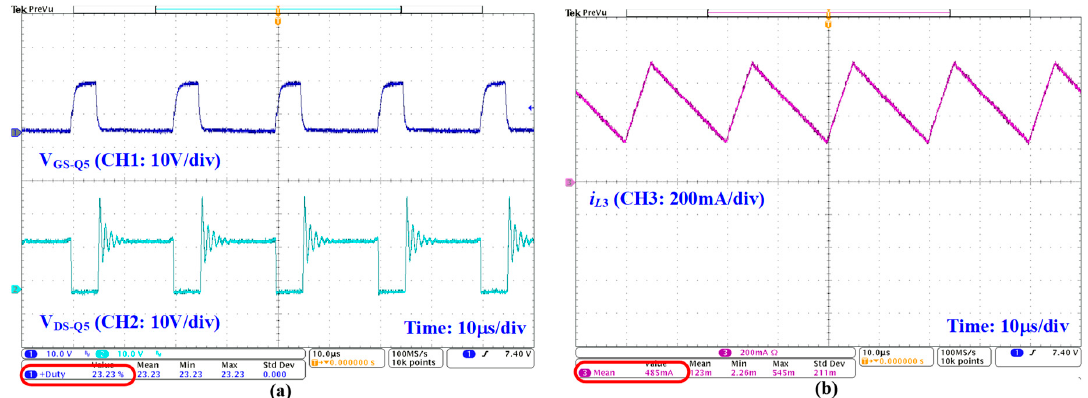
Figure 17. Measured waveforms of PCL 3 with the AVDC method: ( a ) switch voltages of V GS-Q5 and V DS-Q5 , ( b ) inductor current of i L 3 .